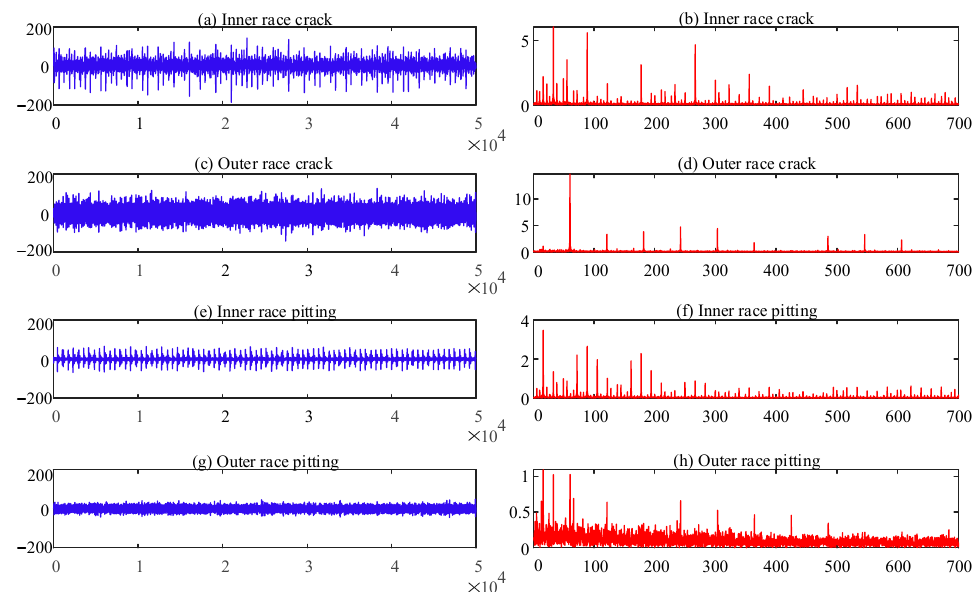
Figure 8. Time domains and spectra of the four fault states: ( a ) time domain of IRC; ( b ) envelope spectrum of IRC; ( c ) time domain of ORC; ( d ) envelope spectrum of ORC; ( e ) time domain of IRP; ( f ) envelope spectrum of IRP; ( g ) time domain of ORP; ( h ) envelope spectrum of ORP.